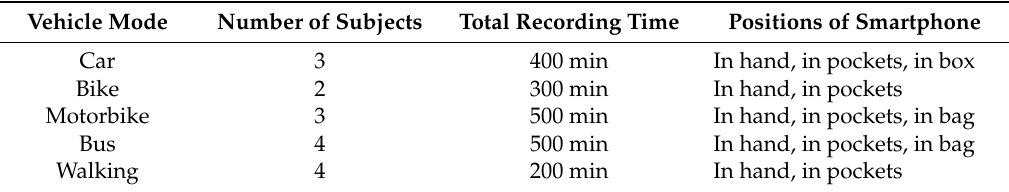
Table 5. Datasets for